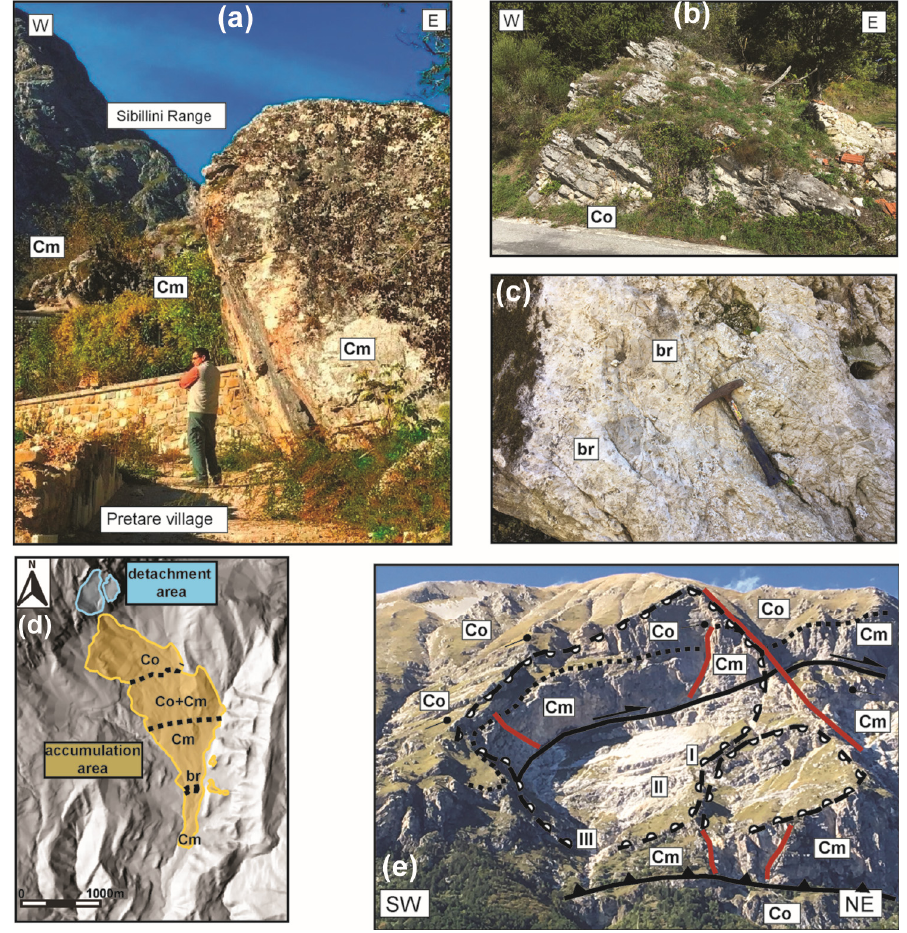
Figure 12. Distribution of lithologies: ( a ) massive calcareous blocks from the Calcare Massiccio Fm.; ( b ) thin bedding featuring the Corniola Fm. blocks; ( c ) breccia texture in a block found in the Pretare village; ( d ) boundaries between blocks with different lithology in the accumulation area and detachment area; ( e ) slope stratigraphy and main morphological features; legend: br = breccia facies; Cm = Calcare Massiccio Fm; Co = Corniola Fm; I–III morphological steps on the main sliding surface.